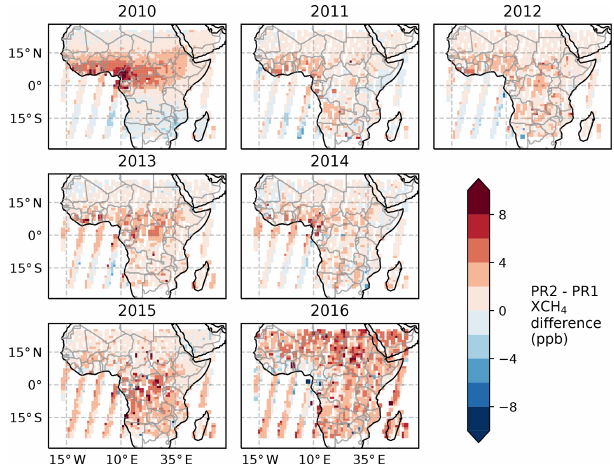
Figure 2. Annual mean differences between PR1 and PR2 proxy XCH 4 data at 1 ◦ × 1 ◦ resolution. PR1 represents the data from Parker et al. (2015). PR2 uses our own CO 2model component, gen- erated from an inversion of GOSAT XCO 2 data to form the proxy XCH 4